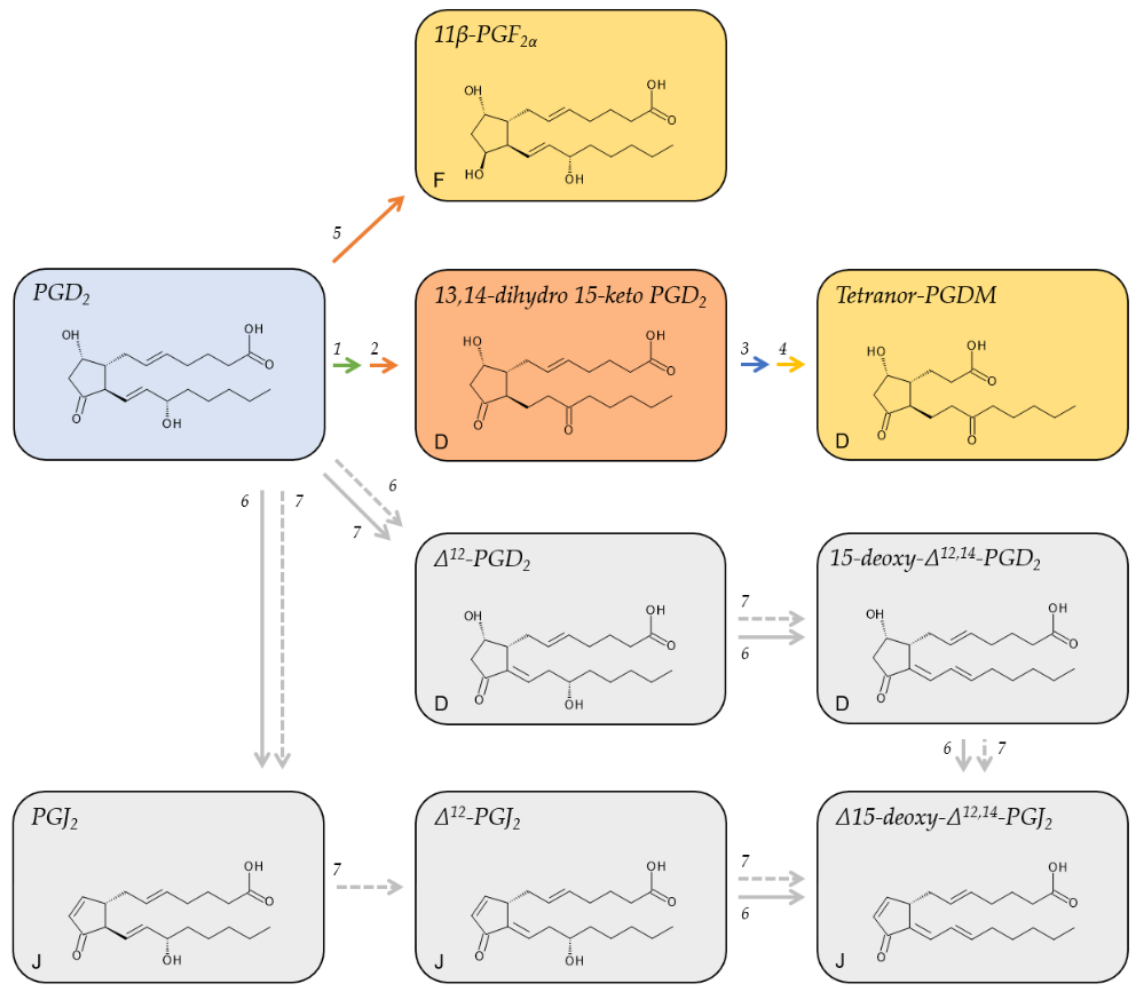
Figure 3. Major metabolic pathways of PGD 2 . Metabolites on a red background are regarded as major plasma metabolites; metabolites on a yellow background are major urinary metabolites; metabolites on a grey background are cyclopentenone derivatives of PGD 2 . Red arrows indi- cate reduction, green, blue, or yellow arrows oxidation, and grey arrows non-enzymatic/albumin mediated reactions. The letters in the lower left corner denote the ring structure of the respec- tive metabolite. 1, 15-hydroxyprostaglandin Dehydrogenase (15-PGDH, EC 1.1.1.141); 2, 15-oxo- prostaglandin ∆ 13-reductase (EC 1.3.1.48); 3, enzymatic β -oxidation; 4, enzymatic ω -oxidation; 5, NADPH-dependent PGD 2 11-ketoreductase (EC 1.1.1.188); 6, albumin-mediated